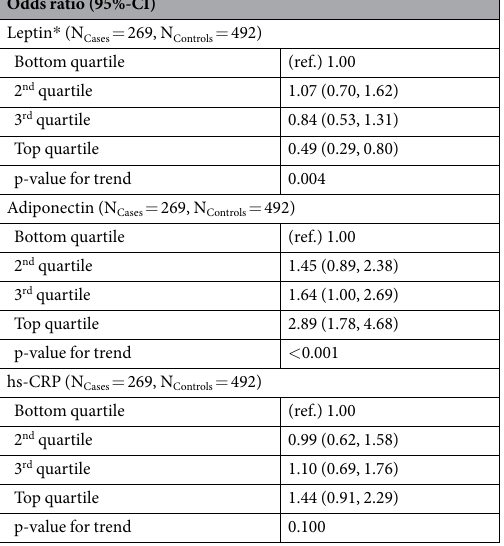
Table 2. Odds ratios for ALS stratified for age, sex and adjusted for school education, occupational work intensity, smoking (ever), family history of ALS and mutually adjusted for serum concentrations of leptin, adiponectin and hs-CRP. * Sex-specific